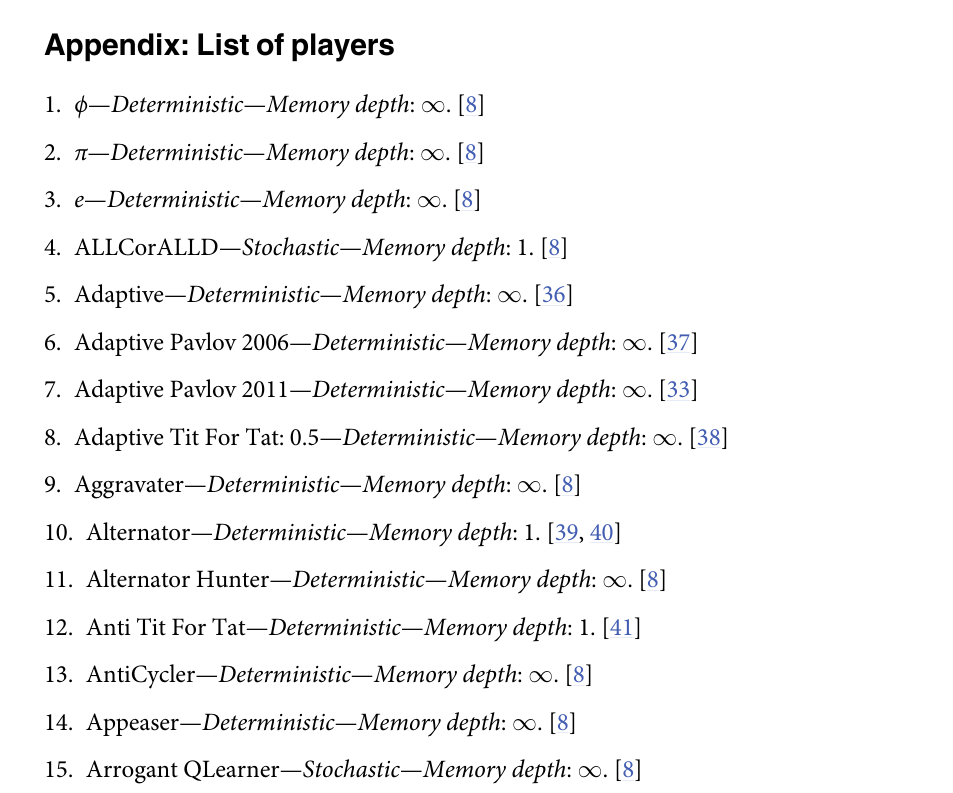
Fig 11. Cooperation rate per round (over 10000 repetitions). Rows correspond to all the strategies considered in this work (ordered alphabetically by name). Columns correspond to round of an IPD match.